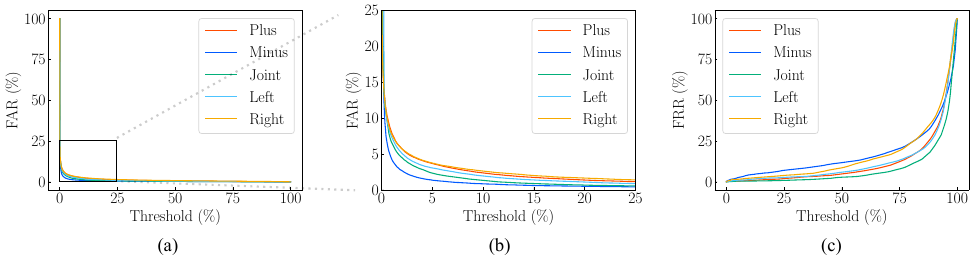
Figure 10. FAR and FRR curves for bilateral and single ear acoustic authentication. ( a ) FAR curve. ( b ) Enlarged FAR curves. ( c ) FRR curve.